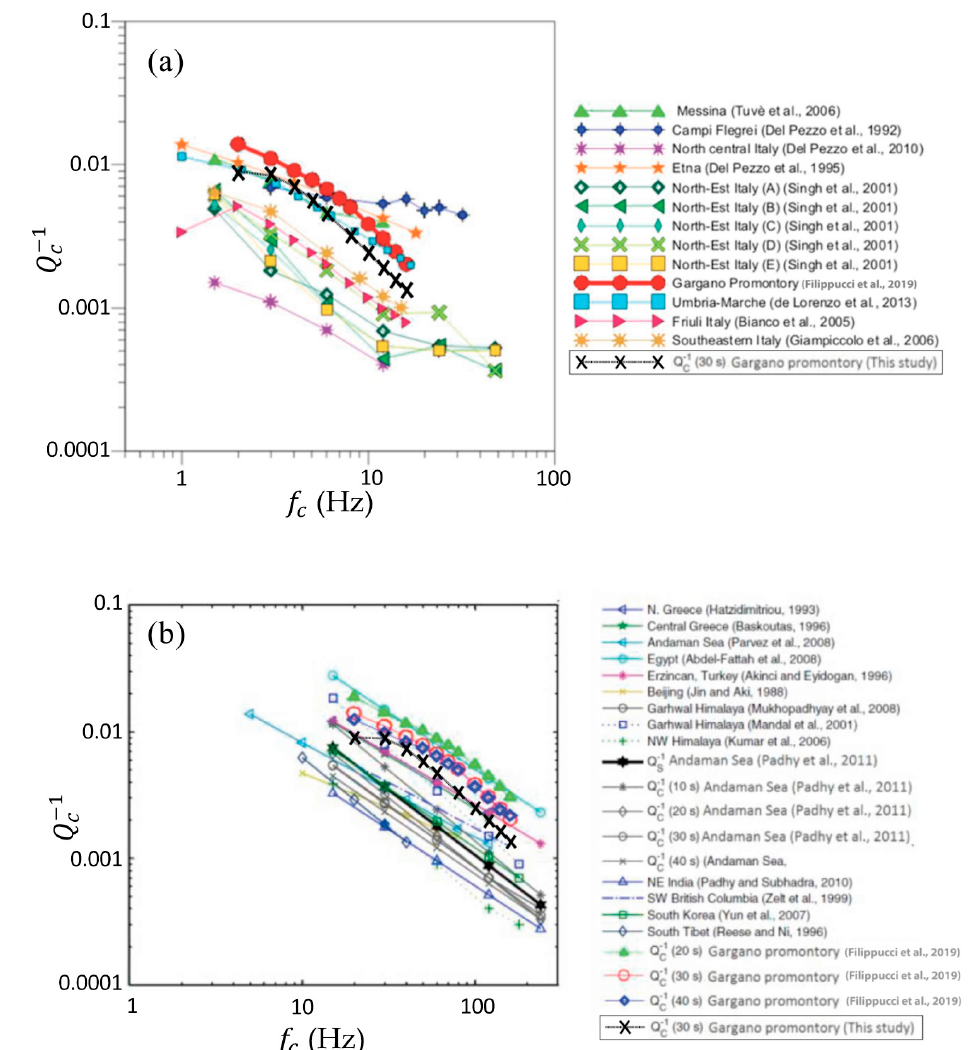
Figure 7. Comparison between the Q c estimates for each central frequency f c obtained in this work ( t L = 30 s) and the literature. ( a ) Literature referring to Q c studies from other areas of Italy (modified from Filippucci et al., 2019 [23]). Letters from A to E refer to the subdivisions of Northeastern Italy by Singh et al. [43]. ( b ) Literature referring to other areas worldwide. Table 1. For each lapse time 𝑡 (cid:3013) , 𝑄 (cid:2868) and 𝛼 estimates, with their errors and the radius of investigation in the Earth lithosphere, are reported.